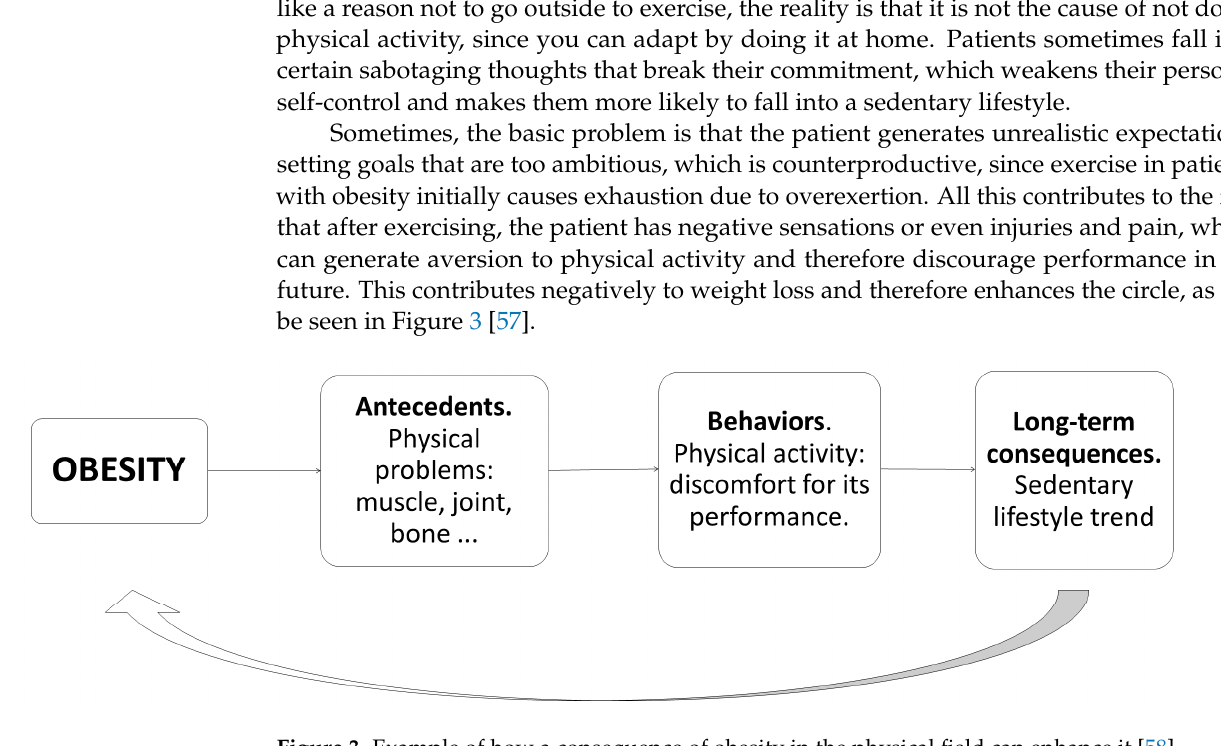
Figure 3. Example of how a consequence of obesity in the physical field can enhance it